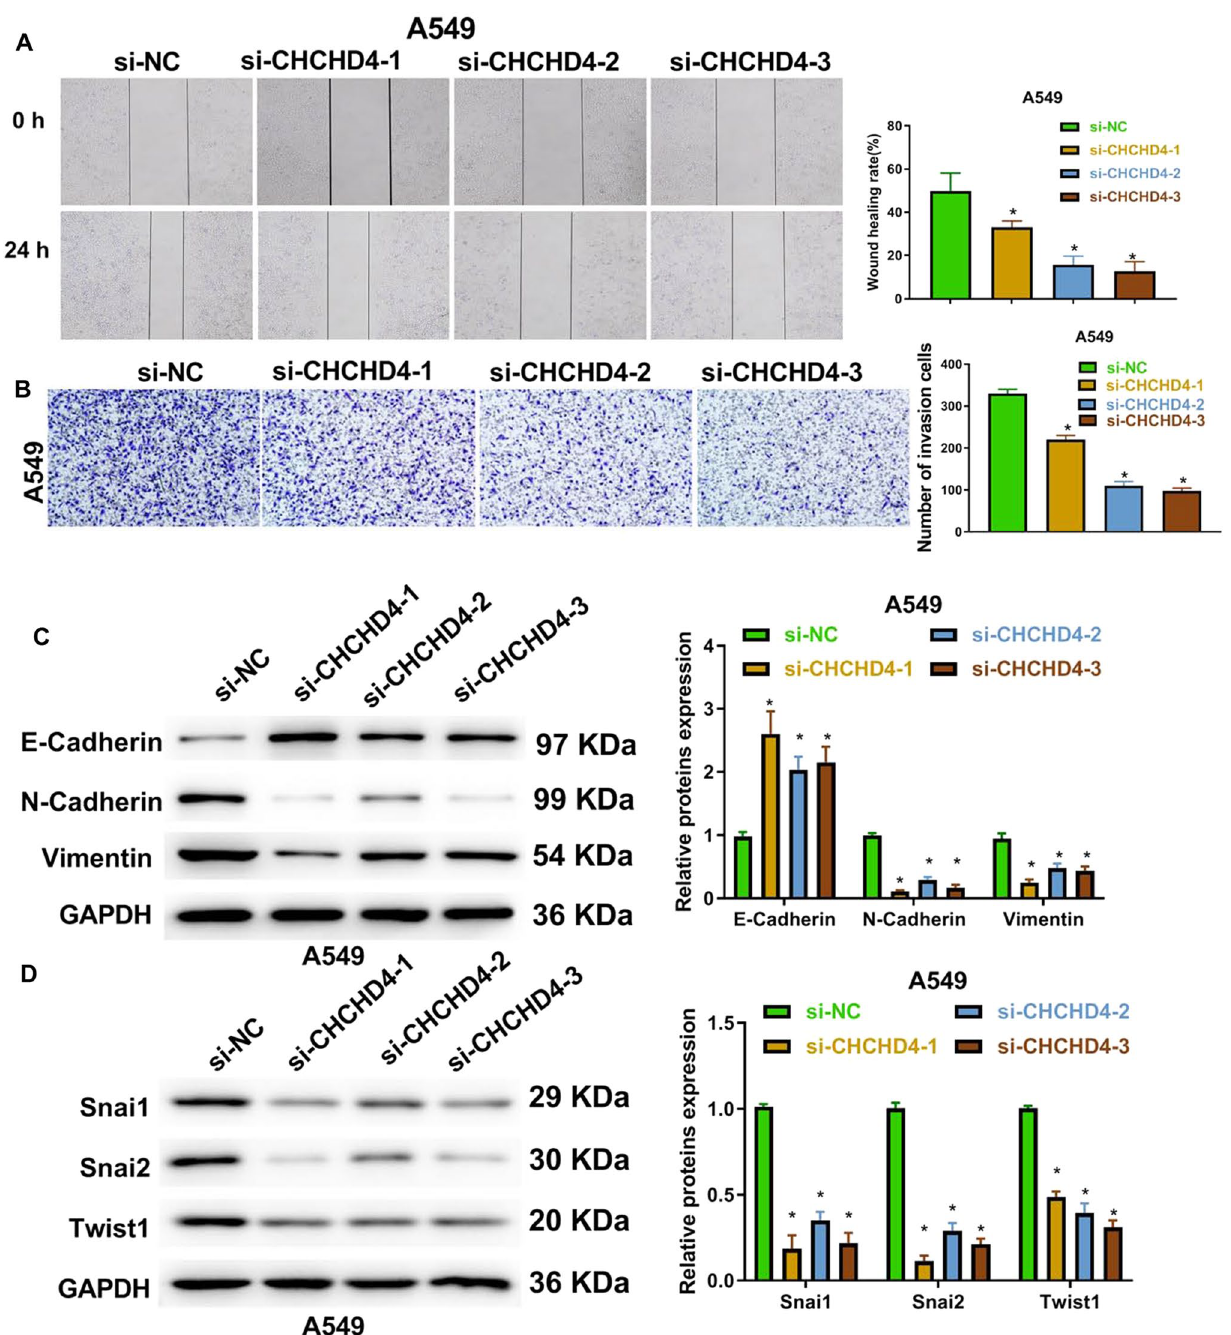
Fig. 3 Knockdown of CHCHD4 suppressed migration and invasion of LUAD cells. After si-CHCHD4-1, si-CHCHD4-2 and si-CHCHD4-3 were transfected into A549 cells, migration was assessed using a wound healing assay ( A ); cell invasion ( B ) was examined using transwell assay; EMT-related proteins were analysed using western blot ( C – D ). * P <